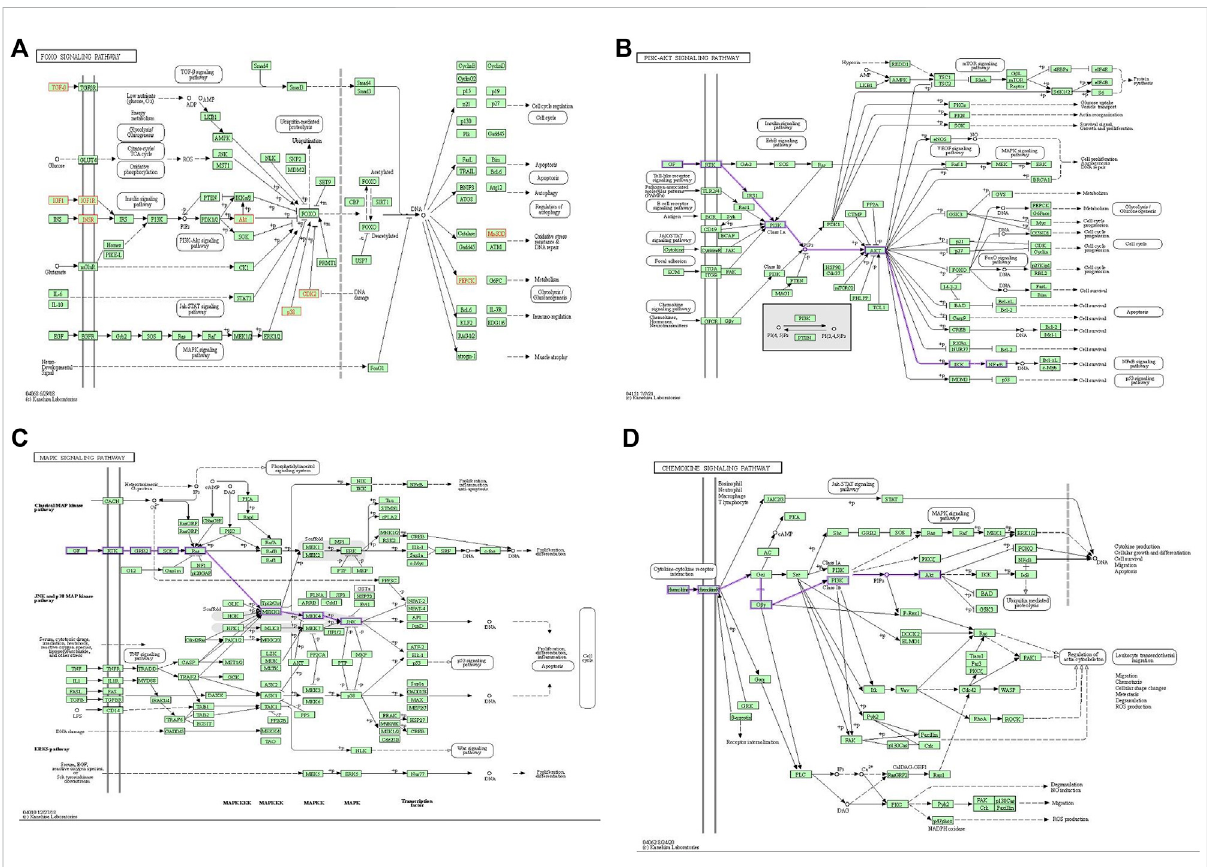
FIGURE 4 PicturesofKEGGgenepathwayisdisplayed. (A) FoxOsignalingpathway;(yellownode)genesexistinginthis IGU andSLEnetwork. (B) PI3K/AKT signaling pathway;(purpleedge) roadmap of genes associated with ournetwork. (C) The MAPK signaling pathway; (purple edge) road map of genes associated with our network. (D) Chemokine signaling pathway; (purple edge) road map of genes associated with our network.